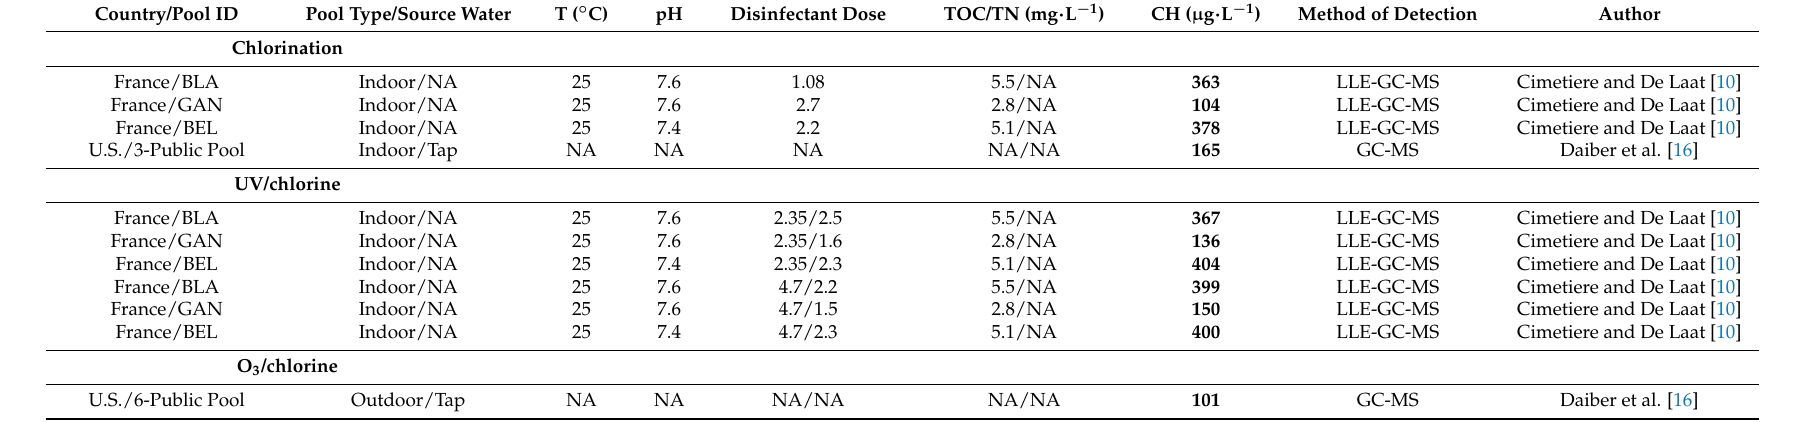
Table A6. Concentration of THAs with different methods of disinfection.